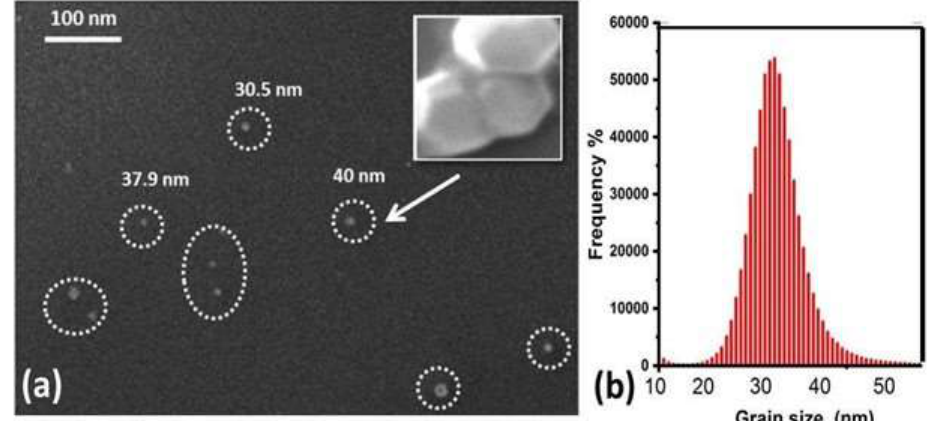
Figure 5 : The morphological characterization of the SPIONs prepared in liquid by laser with a wavelength of 266 nm and 10 J/cm 2 laser fluence for 100 pulses (a) SEM micrographs showing the morphologies of cubic SPIONs in ethanol, and (b) a histogram of the grain size distribution of the SPIONs.